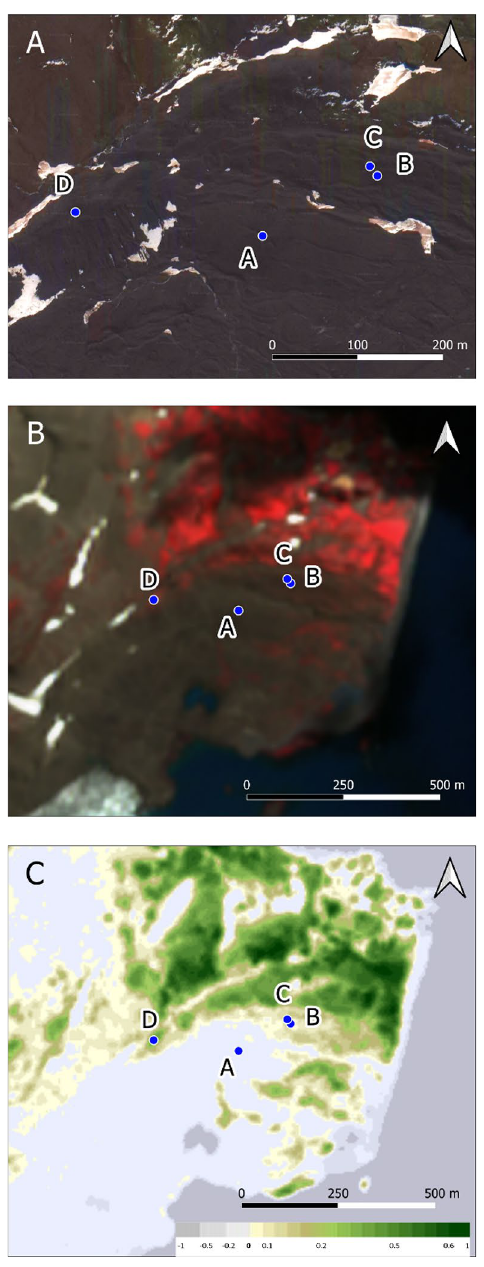
Figure 3. ( A ) High resolution satellite image from 06.11.2016 (Map data © 2016 Google). ( B ) False colour Sentinel-2 image from 19.01.2020 (red = band 8, green = band 4, blue = band 3) for enhanced visualisation of the vegetation. ( C ) Normalized Difference Vegetation Index (NDVI), dimensionless with positive values indicating healthy vegetation and negative values indicating the presence of open water bodies. Contains modified Copernicus